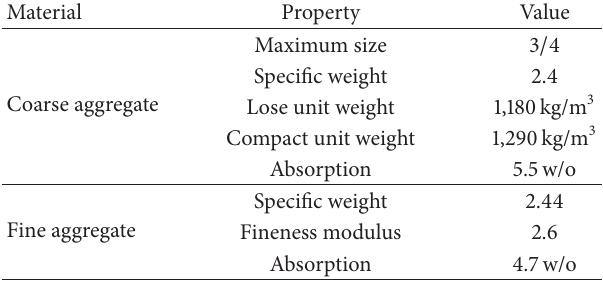
Table 1: Materials properties.